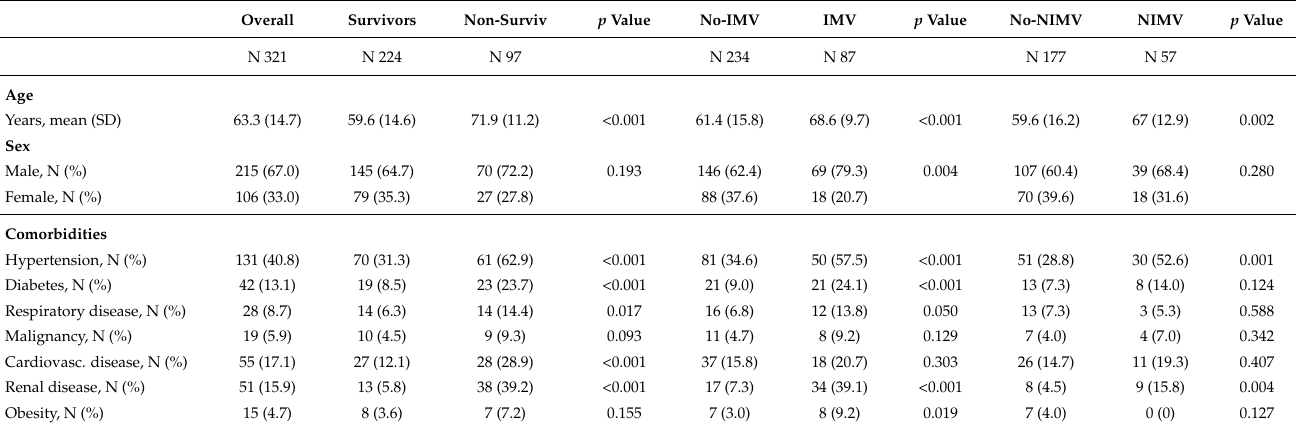
Table 1. Demographic and clinical